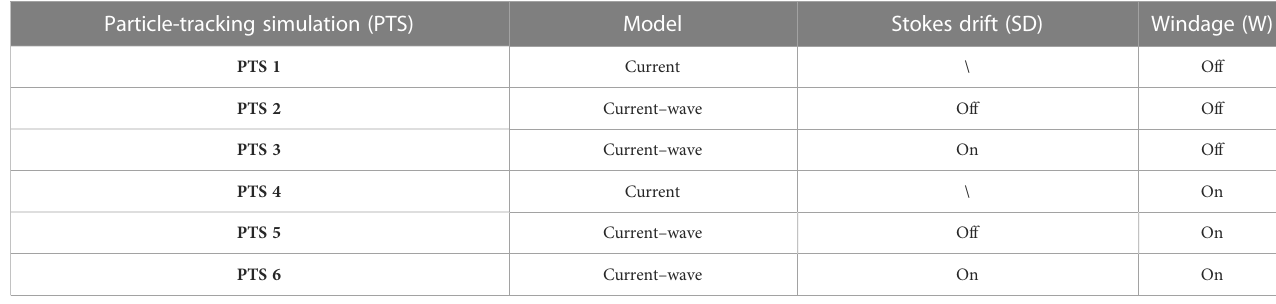
TABLE 2 Experimental settings for particle-tracking simulations.